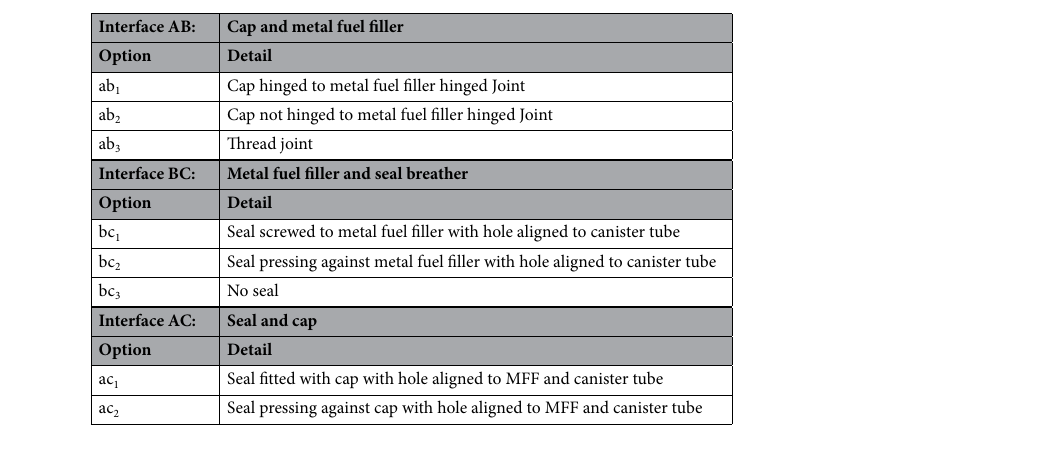
Table 11. Design options for